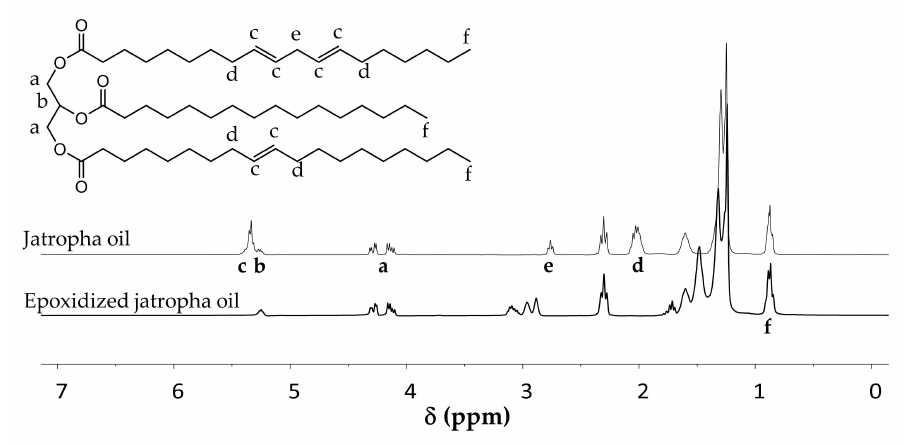
Figure 2. Proton NMR spectra of jatropha oil and epoxidized jatropha oil.